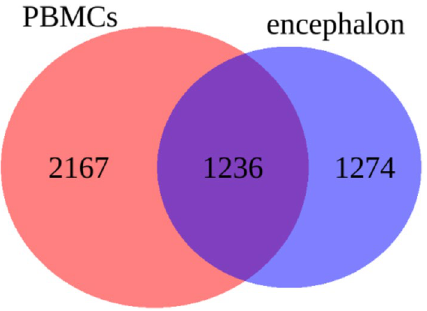
Figure 1. Venn diagram with the number of circRNAs detected in each tissue after filtering for a minimum expression in at least three samples.